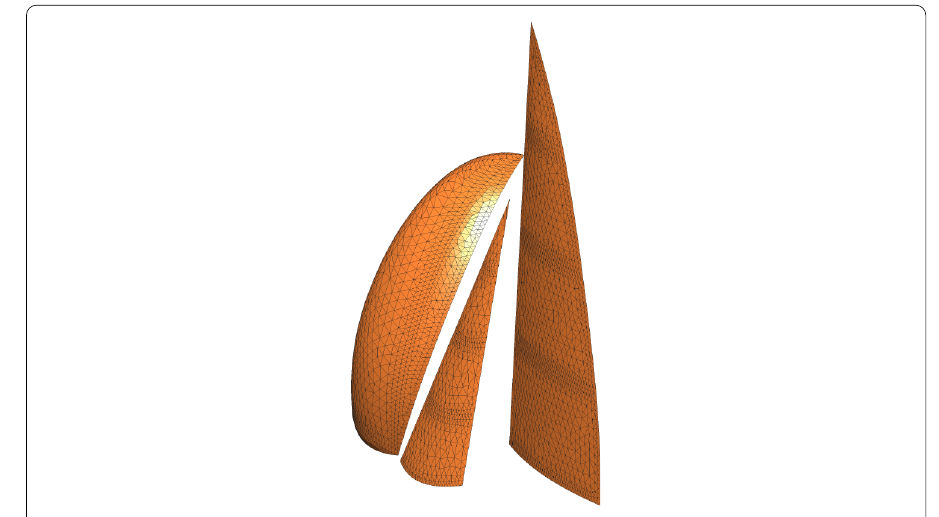
Fig. 34 STL model of sails to be represented within a background